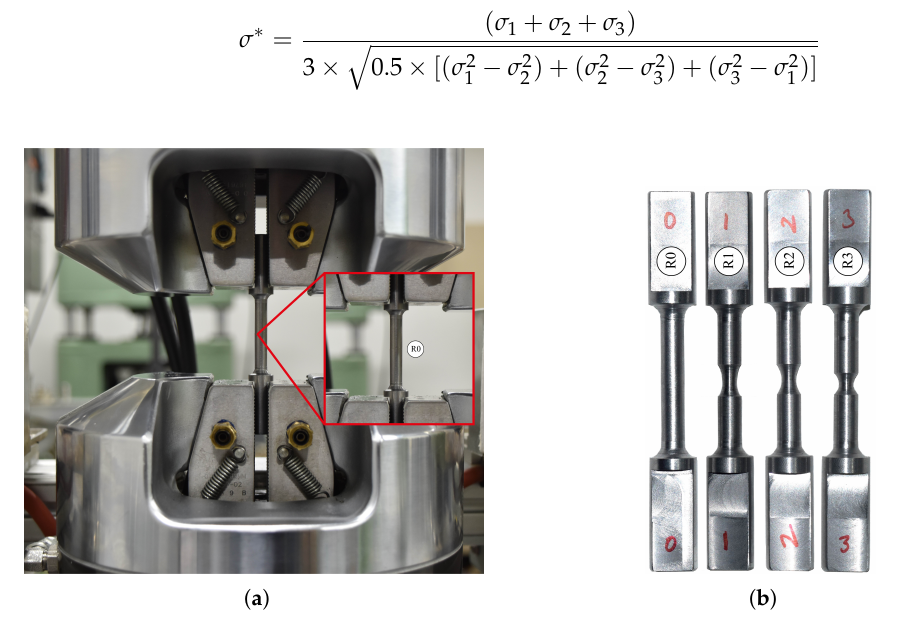
Figure 7. Experimental set-up to perform tension test at room temperature. ( a ) Test machine; ( b ) Un-notched and pre-notched specimens.